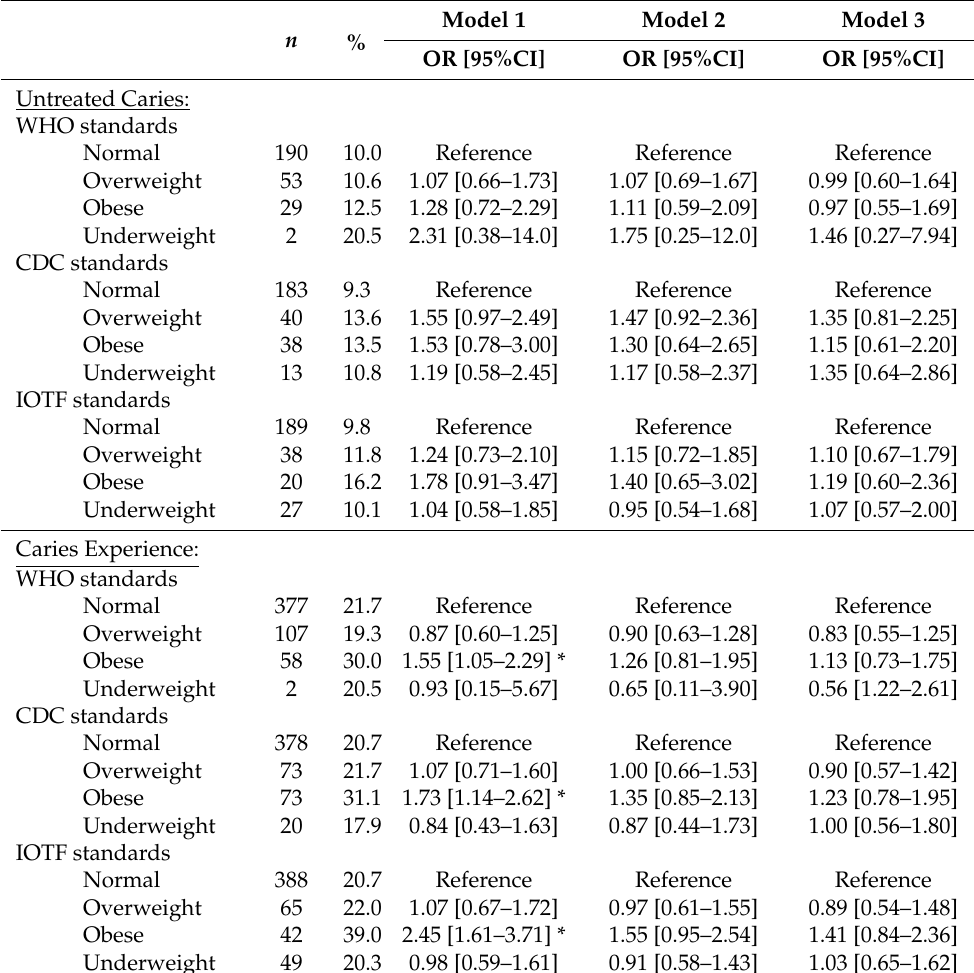
Table 4. Models for the association of BMI groups (as defined by three international standards) with the prevalence of untreated caries and caries experience among 2–5-year-old children ( n =